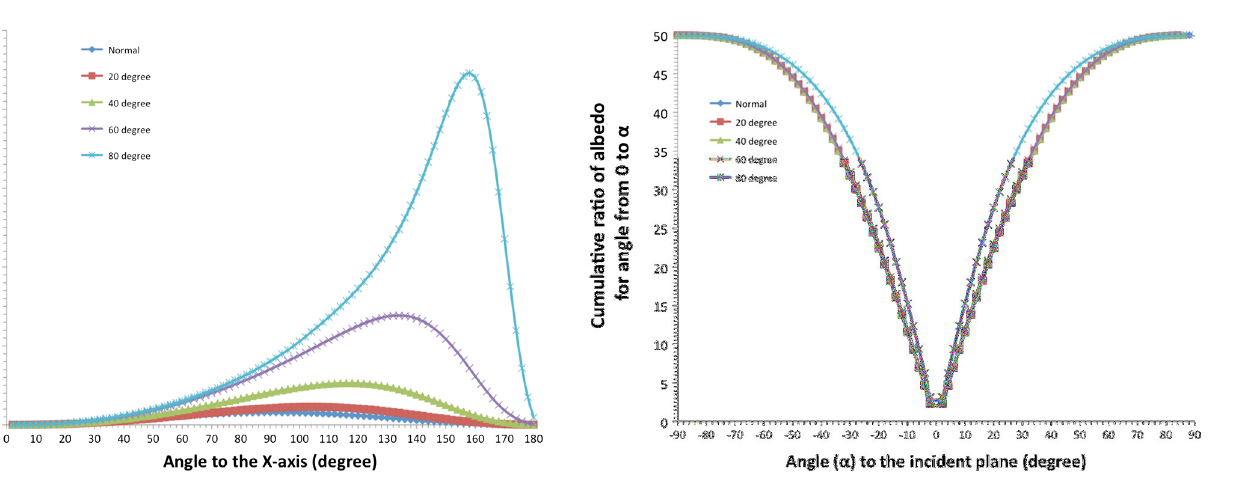
FIG. 5. In-plane scattering angle probability distributions for various incident angles (see legend on plot). Zero degrees represents the normal to the surface.